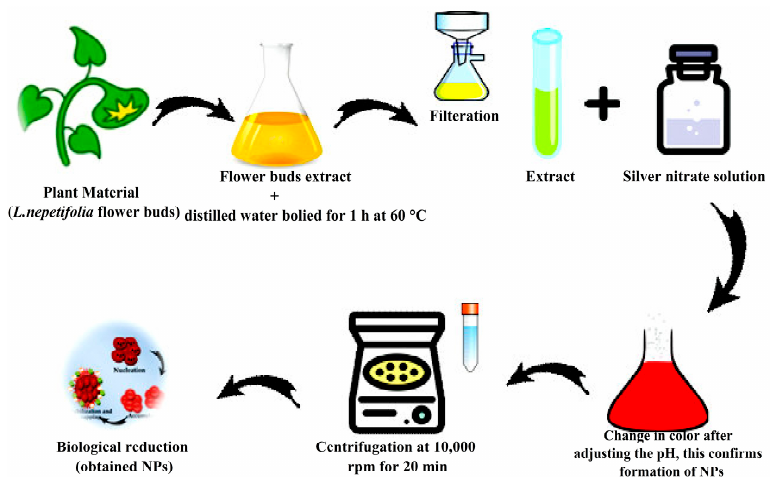
Figure 2. Schematic representation of biosynthesis of